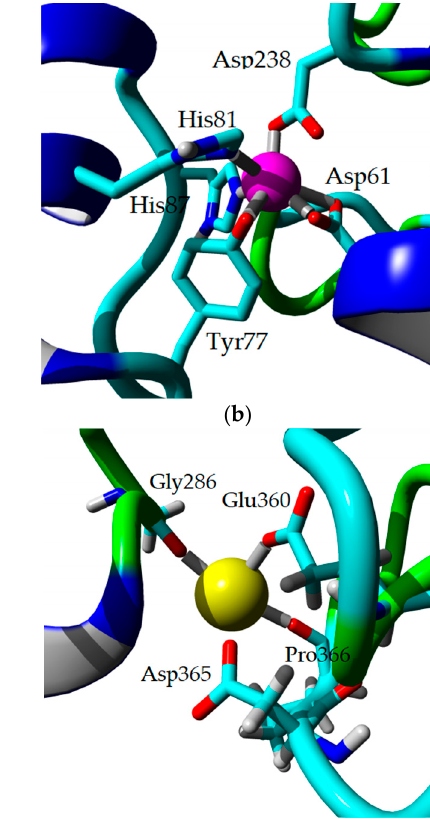
Figure 9. Zinc binding site and calcium-binding site in modeled structure of 5M mutant and Earth-grown T1 lipase crystal structure. ( a ) Zinc binding site in Earth-grown T1 lipase structure. The Zinc ion (Magenta sphere) are coordinated in tetrahedral form by Asp61, His81, His87, and Asp238. ( b ) Zinc binding site in 5M mutant coordinated by Asp61, Tyr77, His81, His87, and Asp238. ( c ) Calcium-binding site in Earth-grown T1 lipase structure coordinated by residues Asp365, Glu360, Gly286, and Pro366. ( d ) Calcium-binding site in 5M mutant coordinated by residues Asp365, Glu360, Gly286, and Pro366.